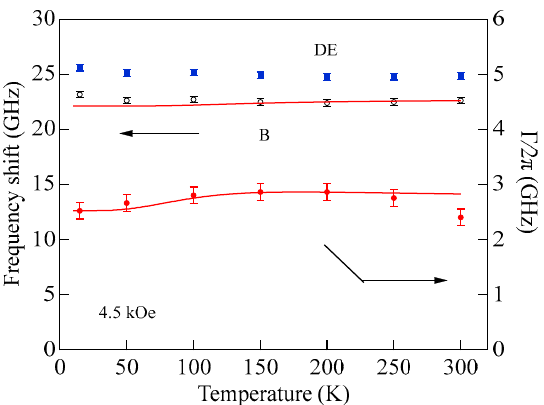
Figure 38. Temperature development of the SPM peak frequencies (Bulk-type ( ○ ) and DE-type ( ■ ) modes) and the damping constant ( • ) at 4.5 kOe. The SPM peak frequencies are determined from the calculated response function S ( Q // , ω ) with Γ /2 π = 0.1 GHz as shown in Figure 36. The solid lines show the calculated SPM peak frequency and peak width when taking into account the magne‑ tization relaxation dynamics [108].